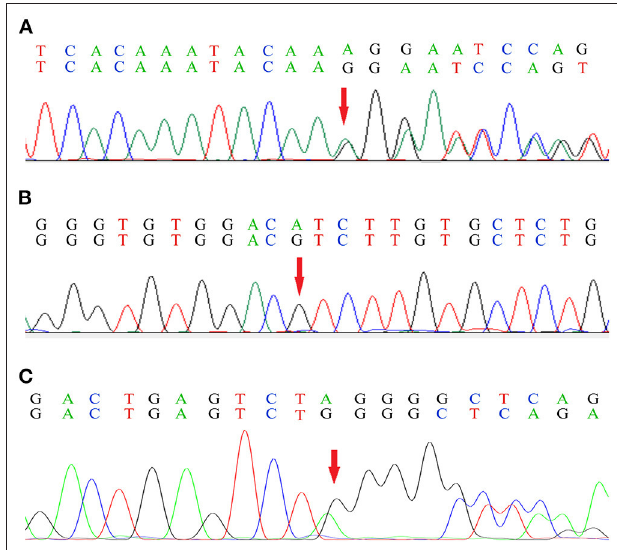
FIGURE 5 | Genetic analysis of the FGA (A) and the LECT2 gene (B) in Patient 1, and the FGA in Patient 2 (C) . The base sequence in the first line of each sub-graph is wild type, and the second line is mutant. Red arrow indicates the mutation site.